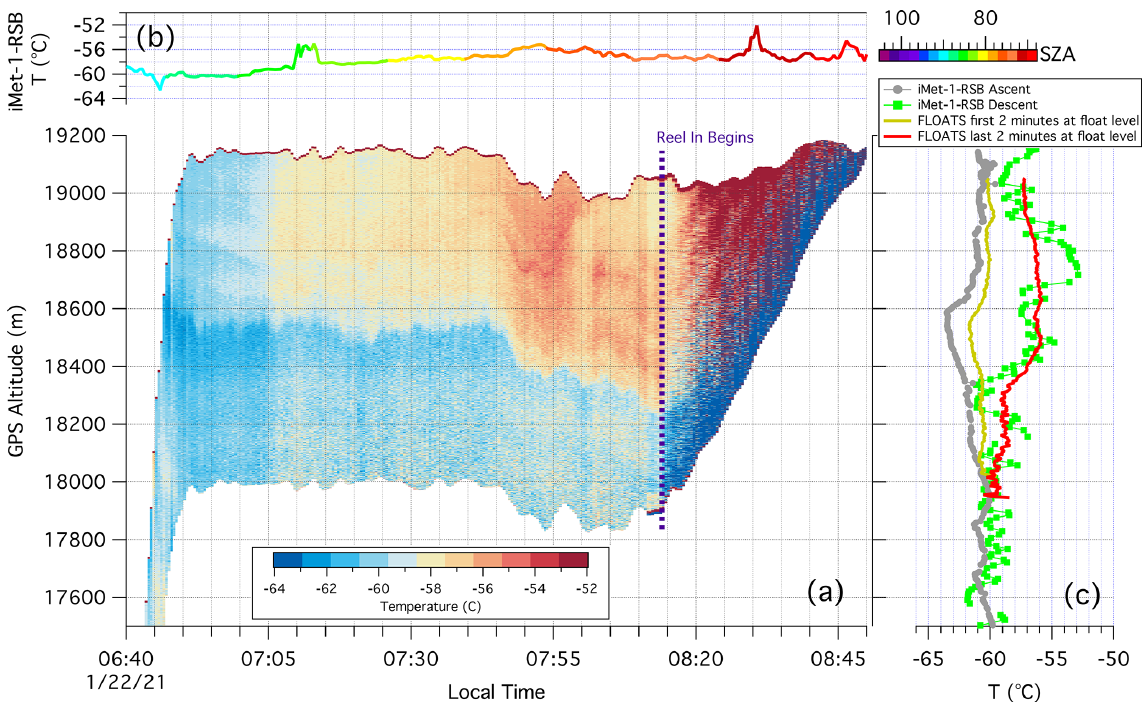
Figure 5. (a) Curtain plot of DTS profile temperatures in ◦ C at or near-flight altitude as a function of altitude and local time (MST). (b) Gondola-level temperature in ◦ C as a function of local time and colored by the altitude-adjusted solar zenith angle. (c) The iMet-1-RSB ascent and descent temperature profiles and FLOATS average profiles in ◦ C as a function of altitude. The time where the fiber-optic reel-in begins is indicated with a dashed purple